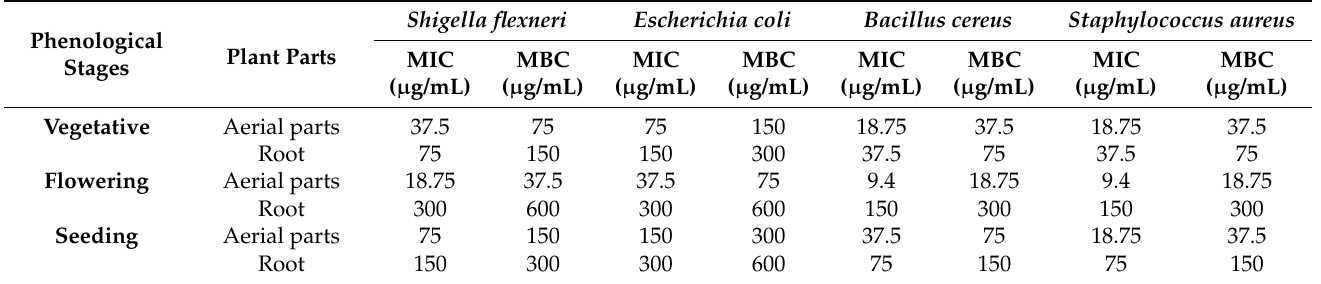
Table 2. The minimum inhibitory concentrations (MICs) and the minimum bactericidal concentrations (MBCs) of the extracts of the T. polium aerial parts and root at different phenological stages for the Gram-positive ( B. cereus , S. aureus ) and Gram-negative ( Sh. flexneri , E. coli )